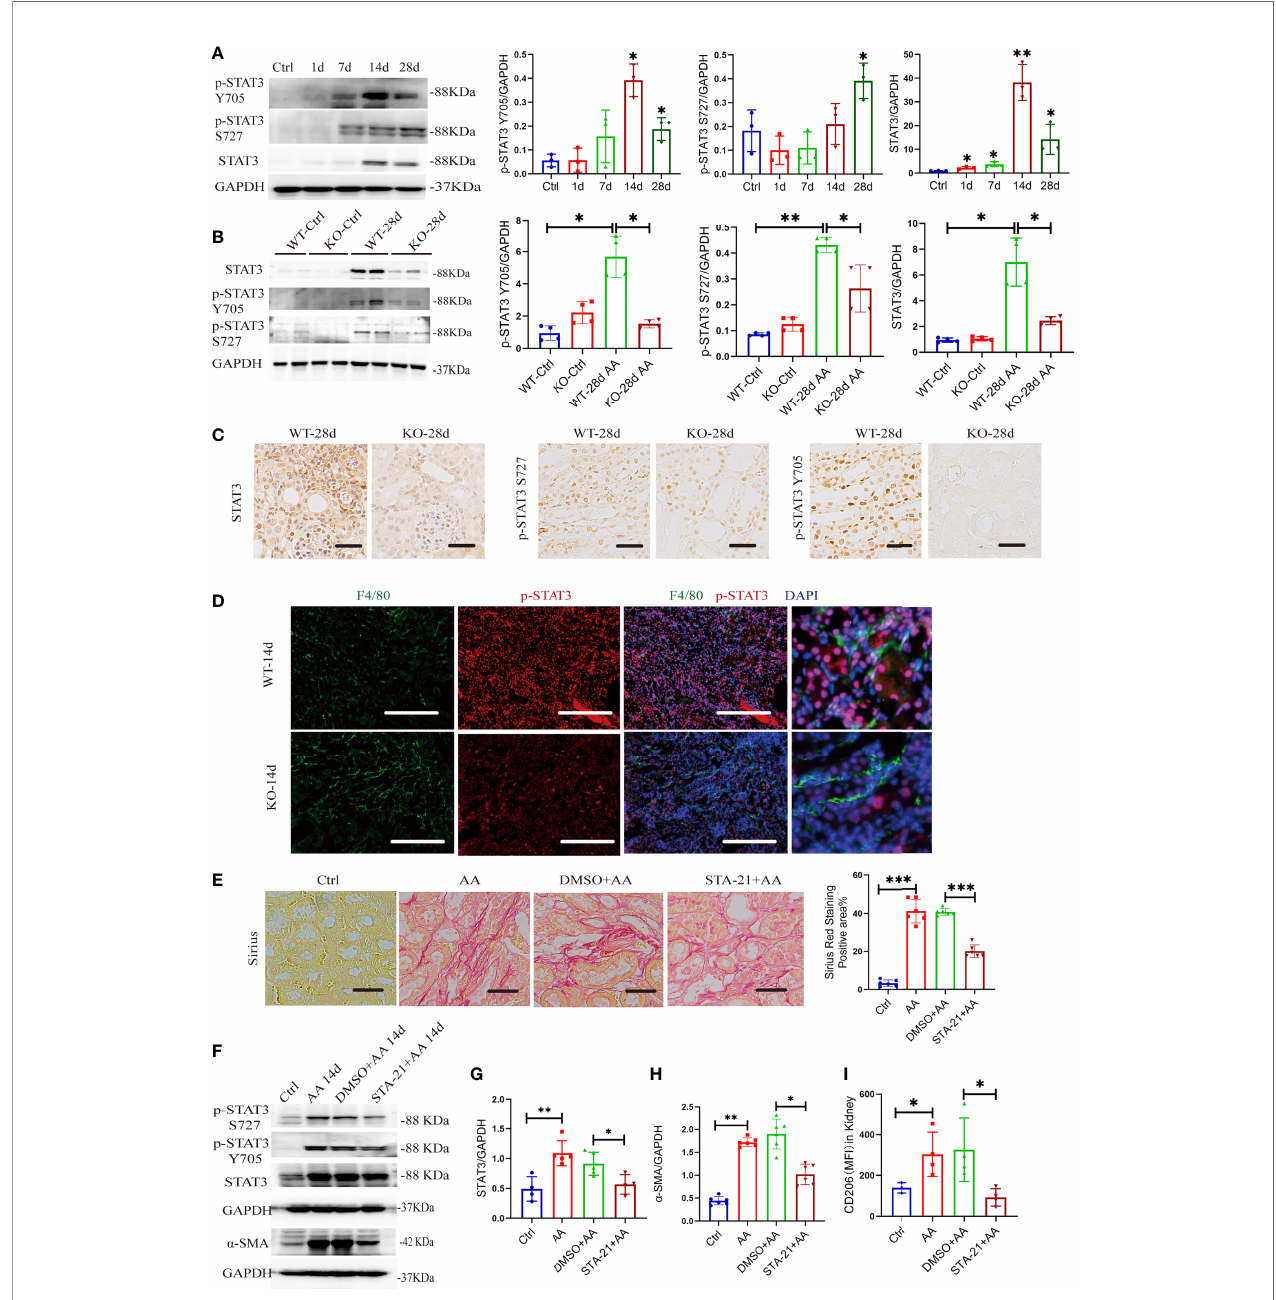
FIGURE 8 | miR-382 indirectly activates STAT3 and gets involved in AA-induced CKD. (A) Images and quanti fi cation of Western blot for p-STAT3 Y705, p-STAT3 S727, and STAT3 in renal tissues in the time course of AAN. GAPDH served as standard. (B) Images and quanti fi cation of Western blot for p-STAT3 Y705, p- STAT3 S727, and STAT3 in renal tissues from WT and KO mice of 28 days AAN. GAPDH served as standard. (C) Immunohistochemistry staining with antibodies against p-STAT3 Y705, p-STAT3 S727, and STAT3 in renal sections between WT and KO mice of 28 days AAN. Scale bars, 200 m m. (D) Images of co-staining for F4/80, p-STAT3, and DAPI in renal sections from WT-14d and KO-14d. F4/80 was stained as green; p-STAT3 was stained as red. Nucleic was stained as blue. Scale bars, 100 m m. (E) Images of Sirius Red staining in these groups. Quanti fi cation of mean positive area for Sirius Red staining in these groups. Scale bars, 200 m m. (F) Images of Western blot for p-STAT3 Y705, p-STAT3 S727, STAT3, and a -SMA in kidney from control, AA 14 days, DMSO+ AA 14 days, and STA-21+ AA 14 days groups. GAPDH served as standard. (G, H) Quanti fi cation of western blot for STAT3 and a -SMA in control, AA 14 days, DMSO+ AA 14 days, and STA-21+ AA 14 days groups. GAPDH served as standard. (I) MFI of CD206+ macrophages in kidney from control, AA 14 days, DMSO+ AA 14 days and STA-21+ AA 14 days groups. *P < 0.05; **P < 0.01; ***P < 0.001;